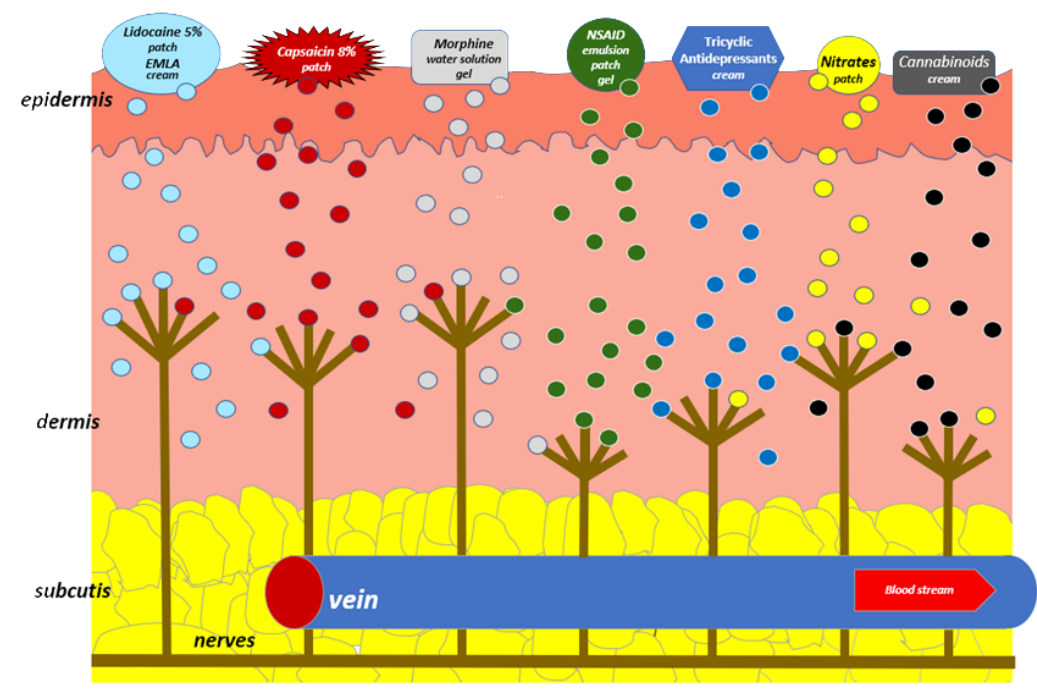
Figure 2. Topical application for locally acting